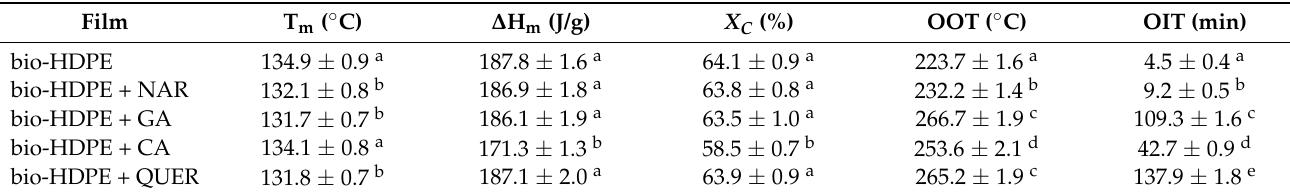
Figure 7. Heating curves obtained by differential scanning calorimetry (DSC) of the thermo-compressed bio-based high-density polyethylene (bio-HDPE) films containing naringin (NAR), gallic acid (GA), caffeic acid (CA), and quercetin (QUER). Table 3. Main thermal parameters of the thermo-compressed bio-based high-density polyethylene (bio-HDPE) films containing naringin (NAR), gallic acid (GA), caffeic acid (CA), and quercetin (QUER) in terms of melting temperature (T m ), normalized melting enthalpy ( ∆ H m ), degree of crystallinity ( X C ), onset oxidation temperature (OOT), and oxidation induction time